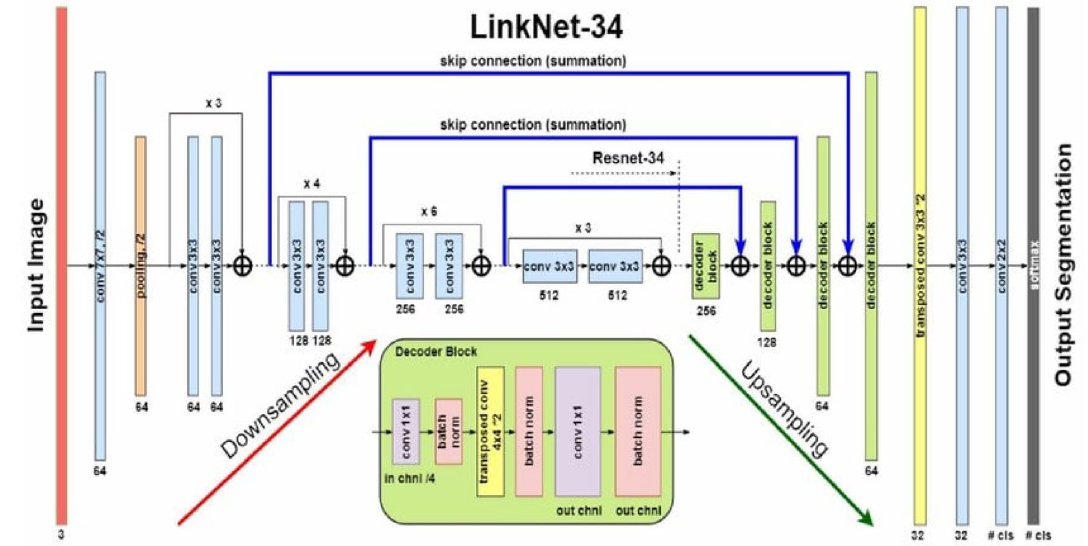
Fig. 3 Link-Net with ResNet-34 Architecture